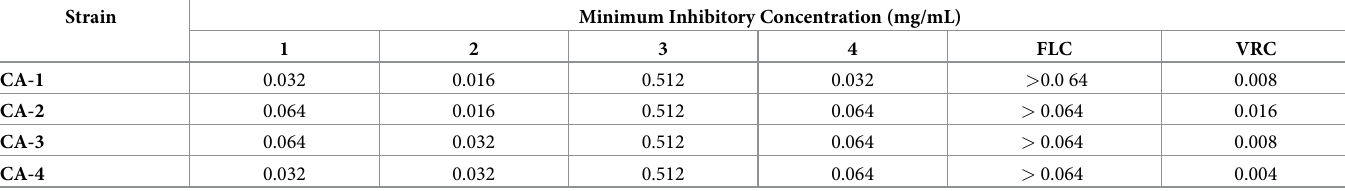
Table 3. Antifungal activity of isolated compounds against clinical isolates of C . albicans .